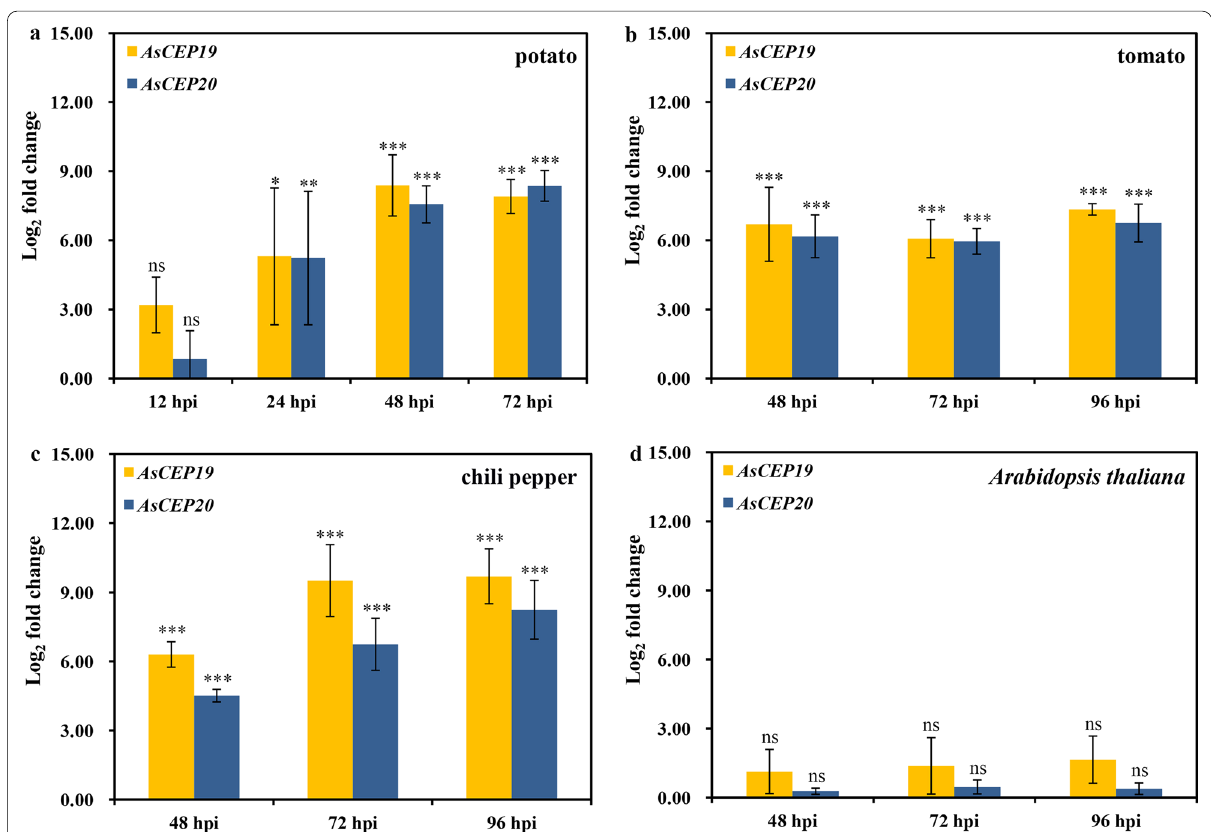
Fig. 5 RT-qPCR analysis of AsCEP19 and AsCEP20 expression during A. solani infection of potato ( a ), tomato ( b ), chili pepper ( c ), and Arabidopsis thaliana ( d ) leaves. The expression levels of AsCEP19 and AsCEP20 in planta at different time points after inoculation were compared with those during mycelial growth of A. solani on PDA. Actin gene ( ACTB ) of A. solani was used as reference gene. Error bars represents